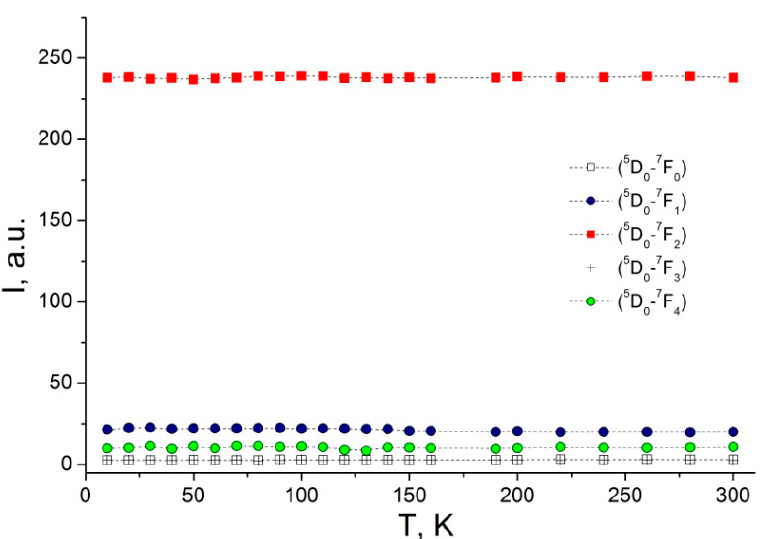
Figure 11. Temperature dependence of integrated emission intensity for different transitions 5 D 0 → 7 F j (j = 0–4).